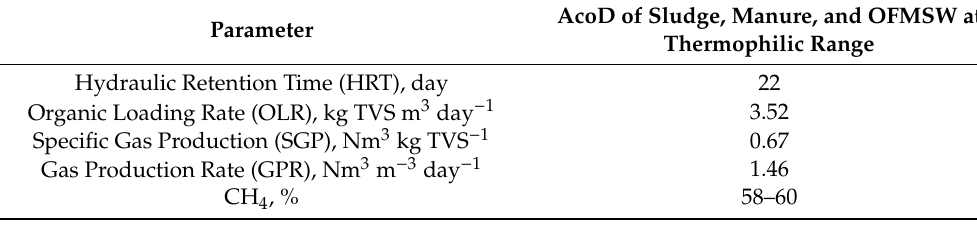
Table 1. Camposampiero anaerobic digestion process performance [23]. OFMSW: organic fraction of municipal solid waste.